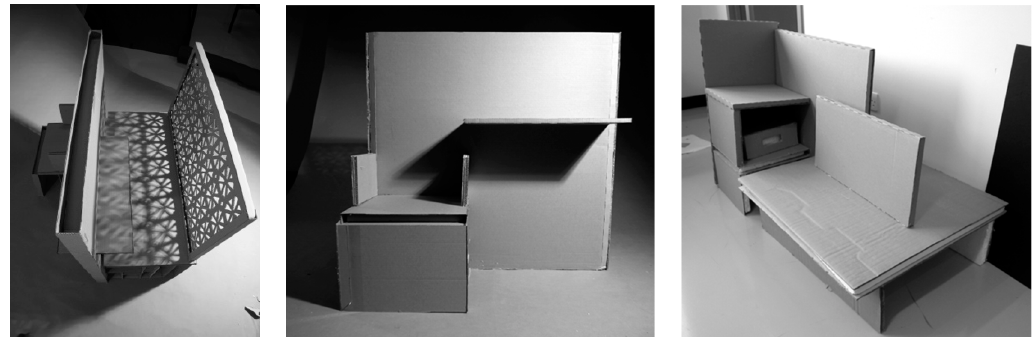
Figure 16. 1:2 scaled prototype made out of corrugated cardboard. Work sample from Project Part III. Courtesy: Alaa Al Hashemi, Mariam Al Nuaimi and Shaikha Al Mulla.